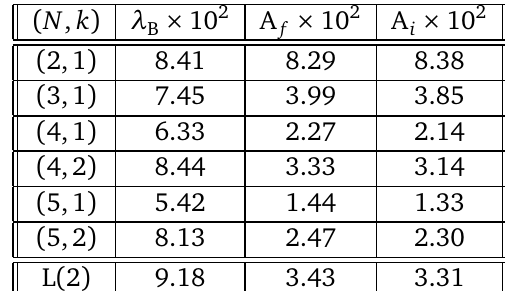
Figure 9: Effect of an applied magnetic field F τ = exp ( − i τ ( h / 2 ) Eq. (115)) on the correlation function of the Noether charges perpendicular to the polarization direction n , shown for (a) N = 2, h = 10 − 3 , (b) N = 2, h = 10 − 2 , (c) N = 3, h = 10 − 2 (with parameters N